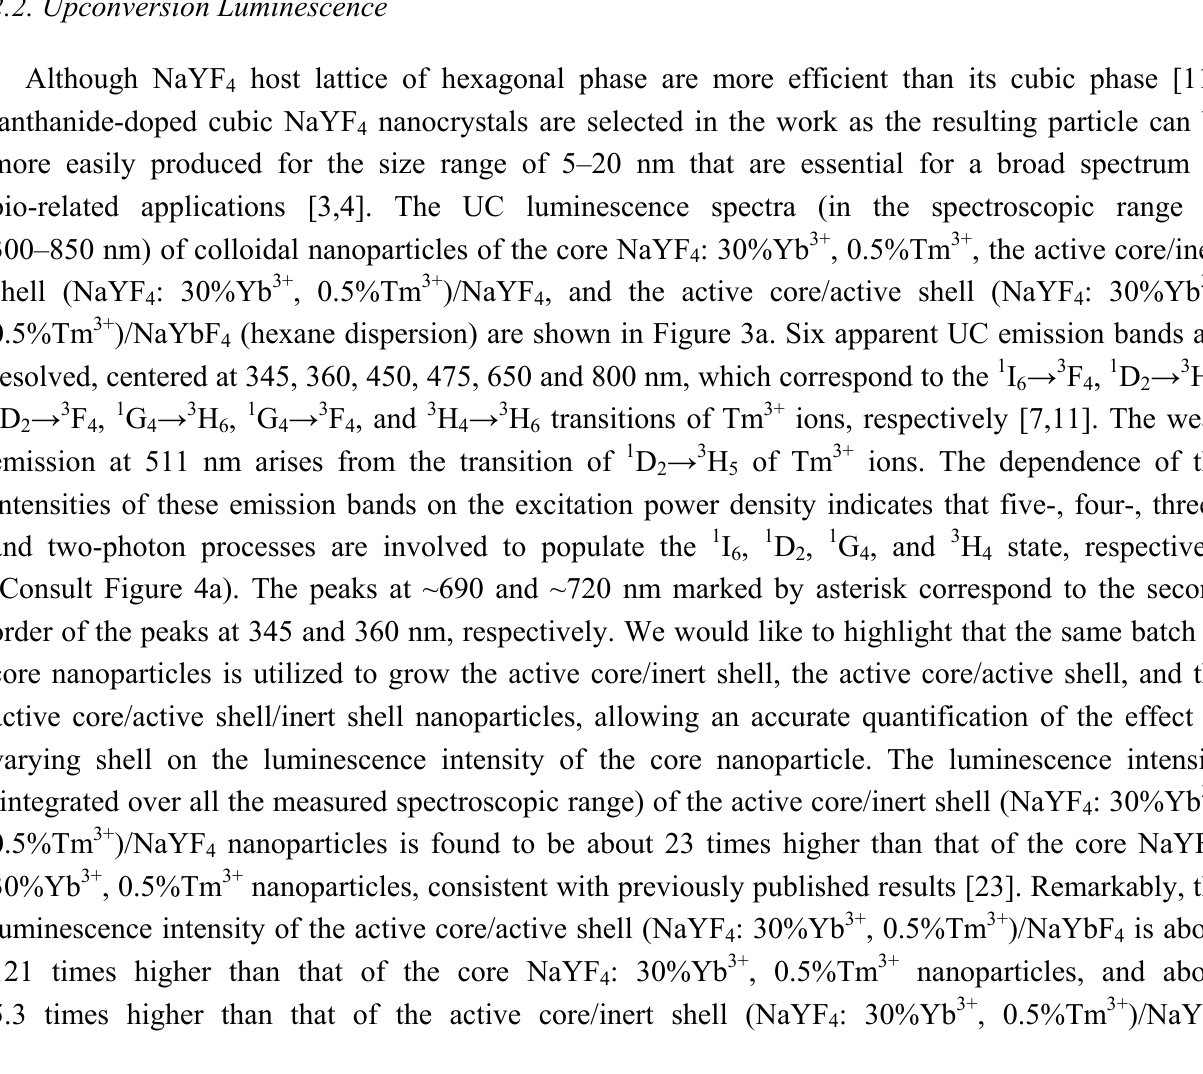
Figure 2. X-ray diffraction patterns of the core NaYF the active core/inert shell (NaYF core/active shell (NaYF core/active shell/inert shell (NaYF